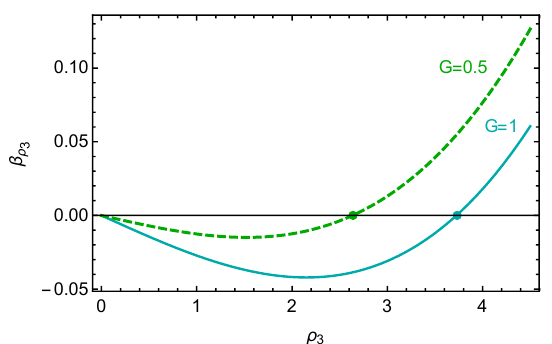
Figure 3 . The beta-function for (cid:26) exhibits an asymptotically safe (cid:12)xed point under the impact of quantum gravity, cf. eq. (3.15) that depends on the microscopic values of the gravity